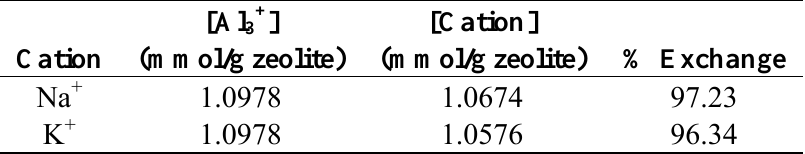
ZSM-5(23) with Na + and K + present as the cations. 4